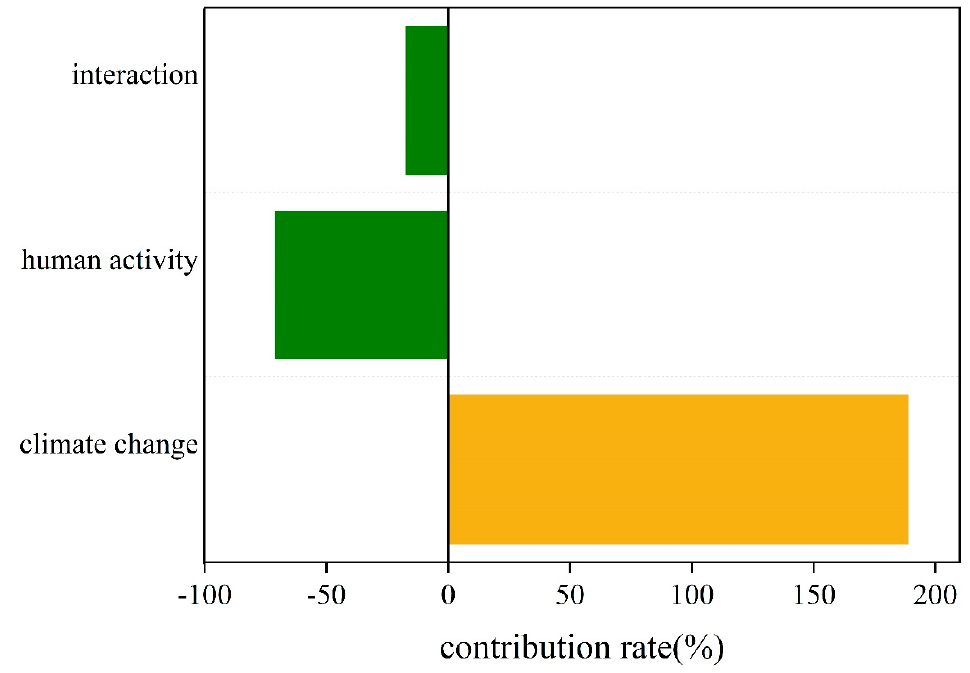
Figure 10. Contributions of the impacts of climate change and anthropogenic activities on runo ff in the Lhasa River during the dry season.